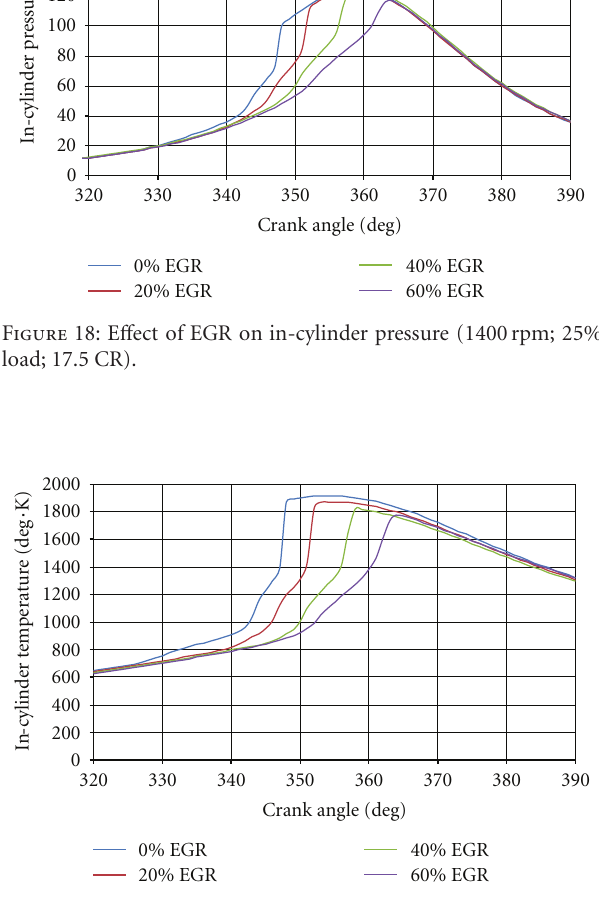
Figure 19: E ff ect of EGR on in-cylinder temperature (1400rpm; 25% load; 17.5 CR).